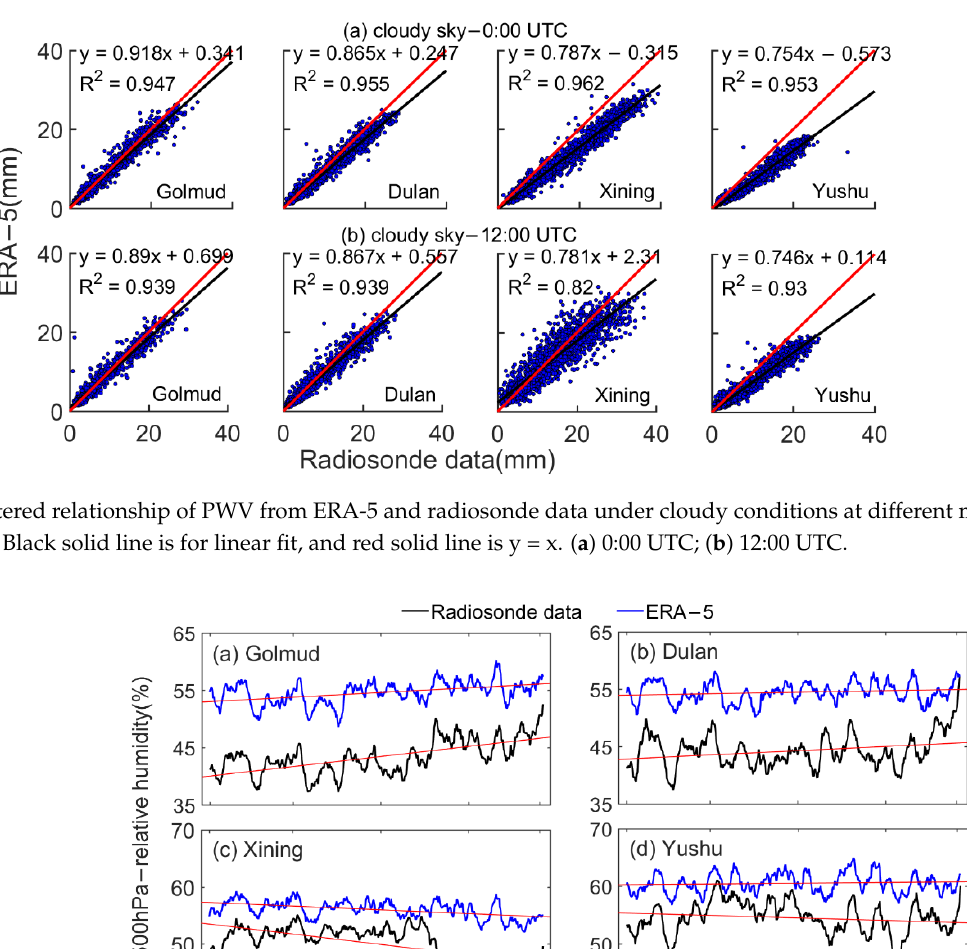
Figure A2. Scattered relationship of PWV from ERA-5 and radiosonde data under clear sky conditions at different meteorological stations. Black solid line is for linear fit, and red solid line is y = x. ( a ) 0:00 UTC; ( b ) 12:00 UTC.